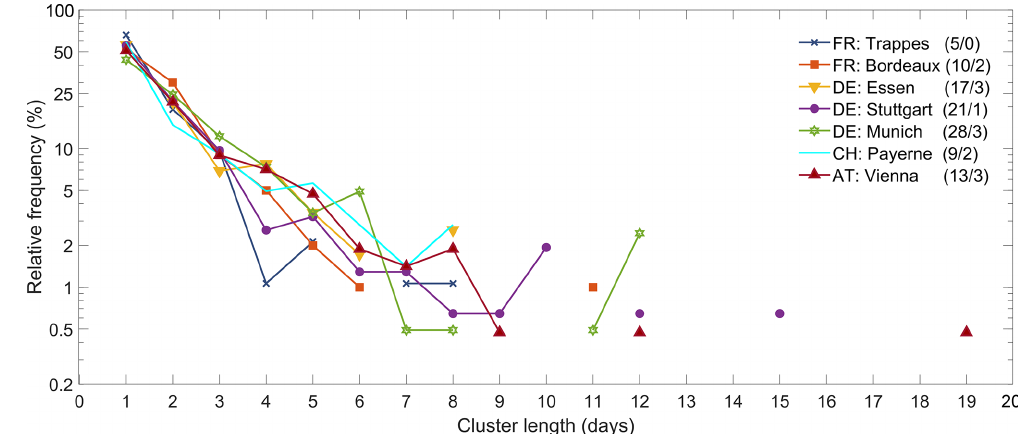
Figure 15. Relative frequency of the length of consecutive days exceeding the basic criterion for concurrent events with low stability (SLI < 0K) and weak flow ( V 500 < 10ms − 1 ) at the seven sounding stations (Trappes, Bordeaux, Essen, Stuttgart, Munich, Payerne, Vienna) during 1981–2017 (May–June). Maximum days with event persistence n (including skip days m ) during the extended study period in 2018 (May–June) are shown in the legend ( n/m